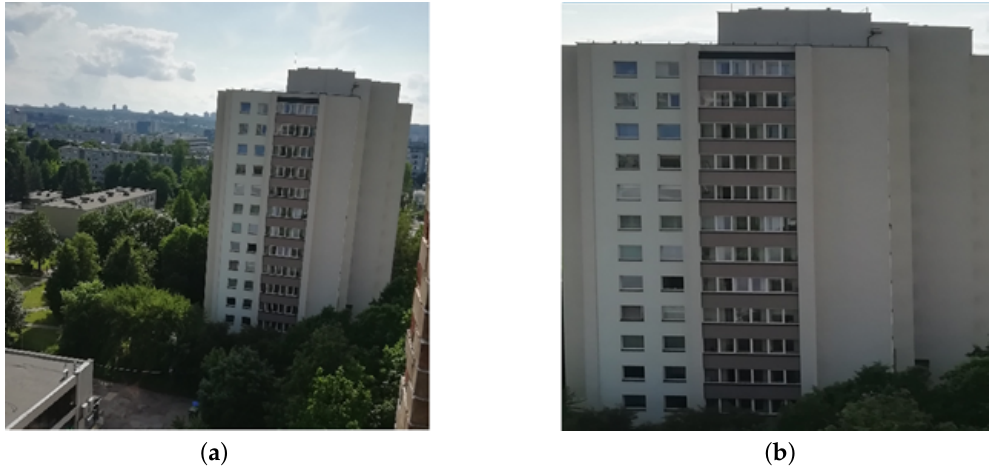
Figure 6. Example of building façade detection: ( a ) the original image obtained, and ( b ) the trans- formed image in order to have only a view of the façade exactly from the